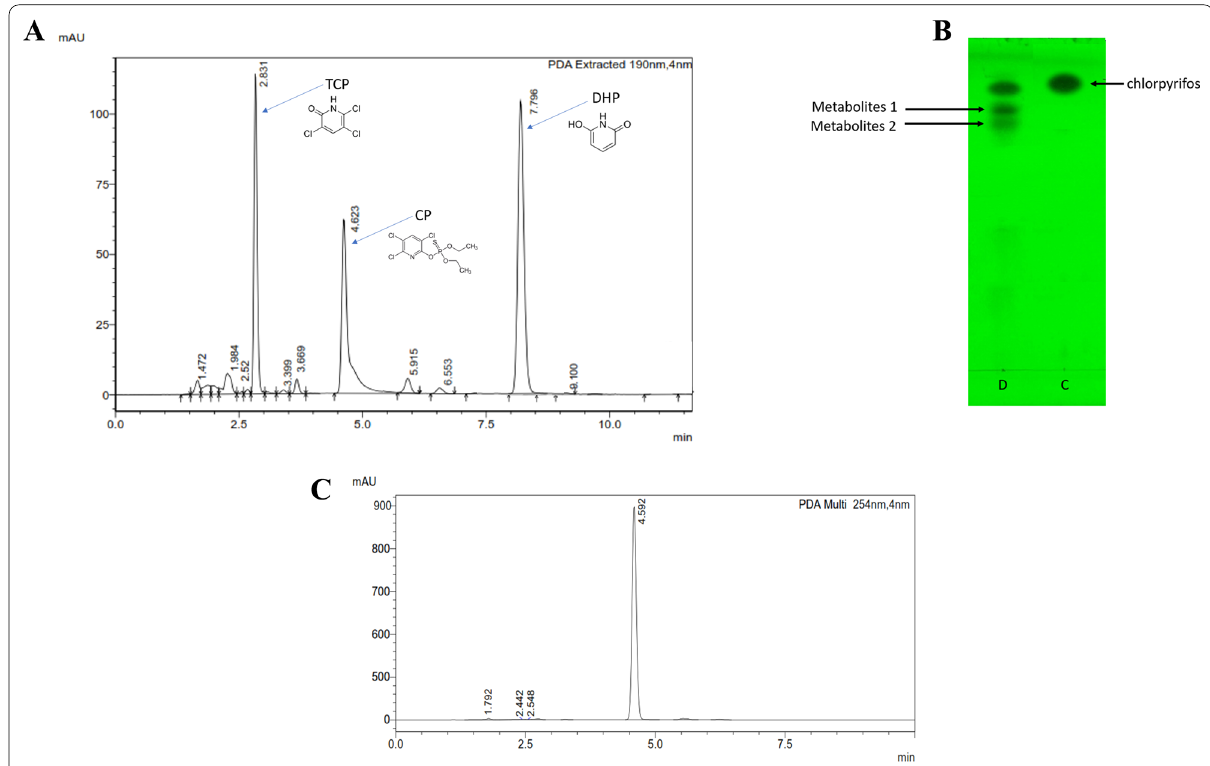
Fig. 4 A HPLC profile of CP metabolites by HM01, where a sample was harvested after 10 h, B TLC profile of CP metabolites by HM01, where metabolite 1 and 2 are identical to TCP and DHP with CP, wherein D is degradation sample, C is control (parent compound), C chromatogram of CP